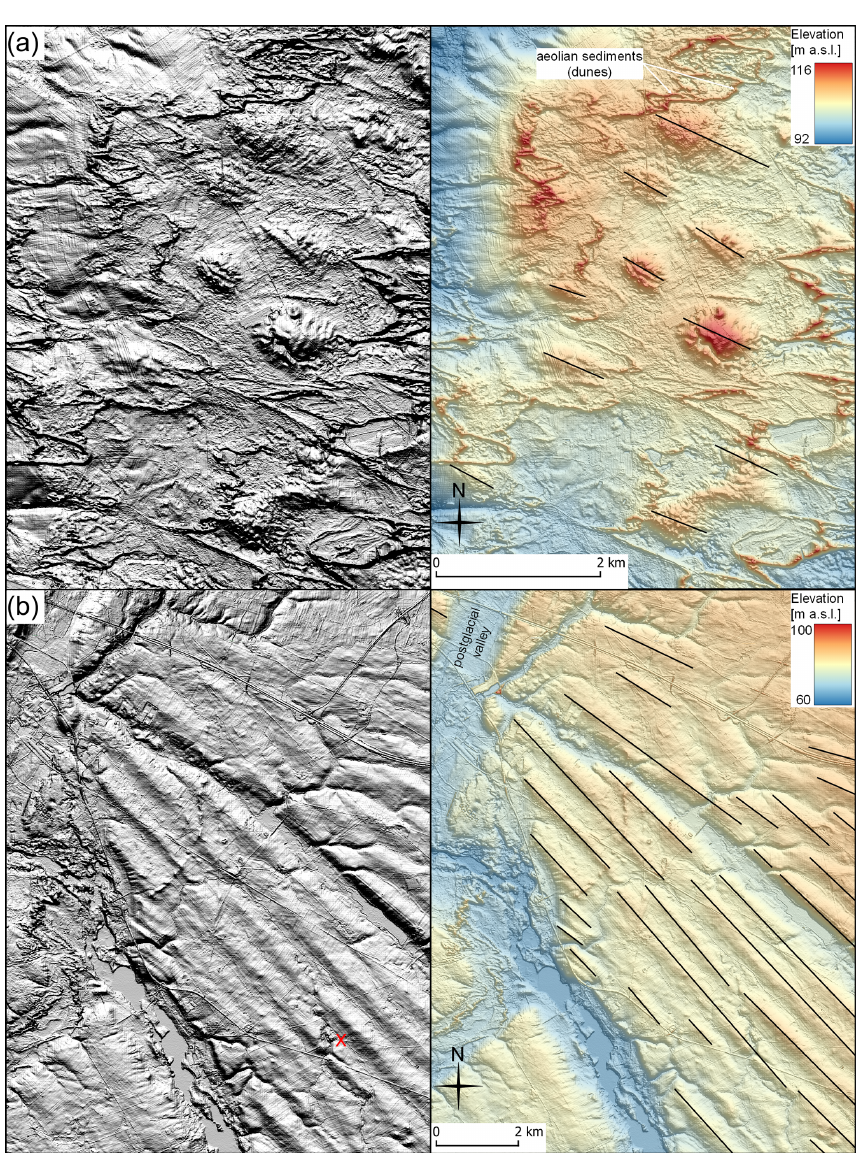
Figure 5. Plain hillshade model (left) and DEM superimposed on hillshade model (right) with mapped (a) drumlins and (b) MSGLs as polylines along their crests. Where discontinuities in landforms (e.g. indicated with red X in b – hillshade) were interpreted as arising from postglacial activity from the action of water erosion, aeolian processes, or anthropogenic activity, the shape of the original landform was